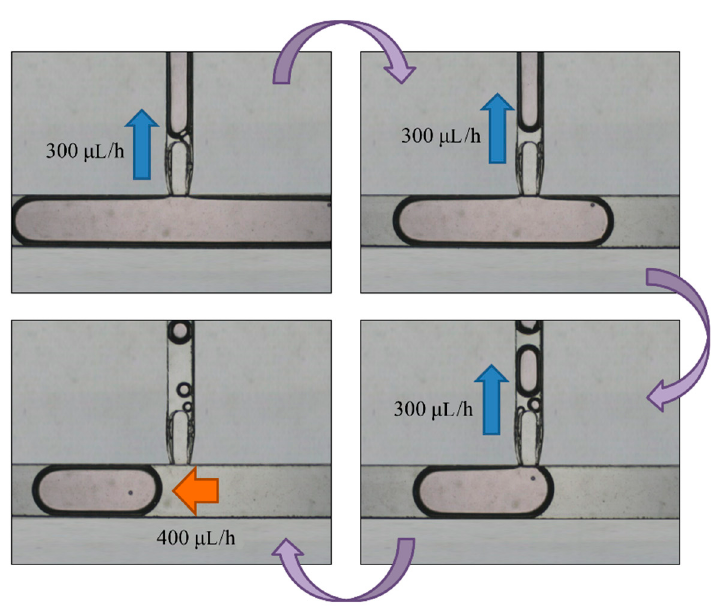
Figure 9. An enlarged droplet was pushed to the replacement area by the oil inlet at a flow rate of 400 μ L/h. We then turned off the oil inlet and opened the replacement area inlet to absorb the medium from the droplet at 300 μ L/h. Finally, we stopped the absorption and opened the oil inlet to cut off the droplet. The 100- μ m bead was not taken out because of the blocking of the fork-shaped channel.